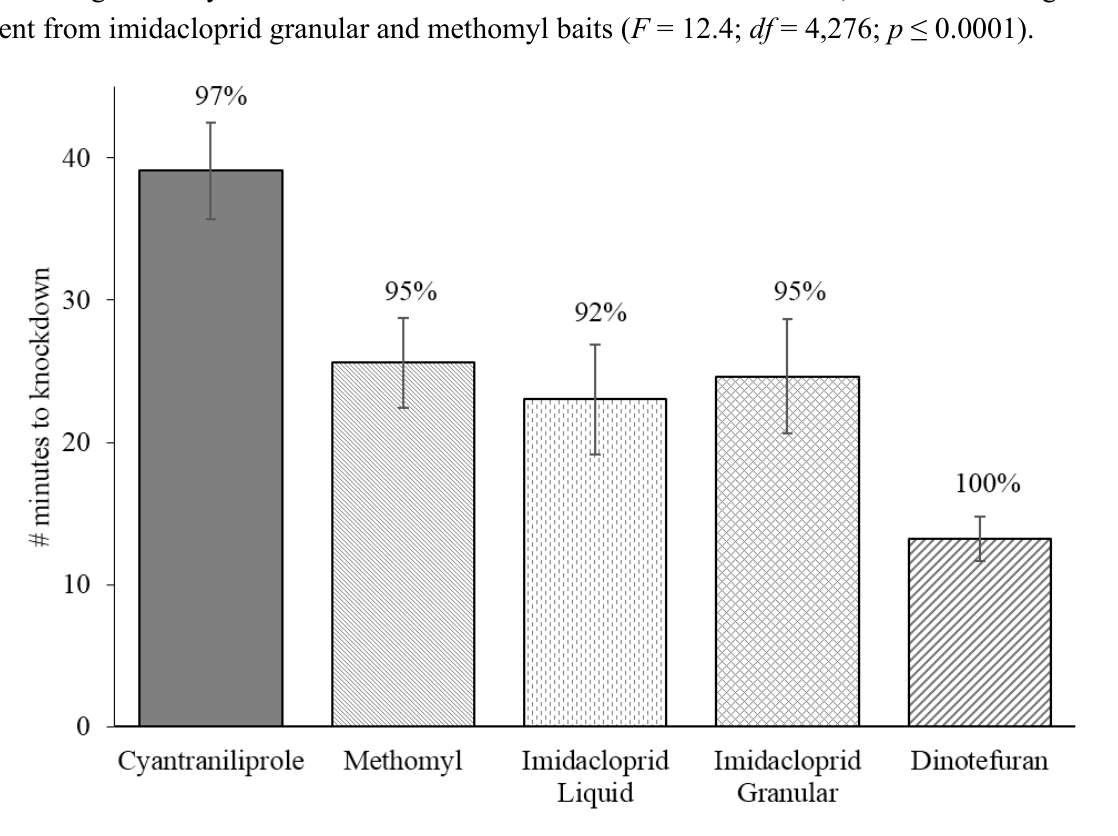
Figure 2. Mean (±SEM) time to knockdown of flies after ingestion of different fly baits. Four replications of 15 flies were allowed to feed on the baits in a no-choice bioassay for a total of n = 60 for each fly bait. Note: Percent knockdown of flies (numbers above bars) used in time to knockdown experiment are shown in Figure 3 as week